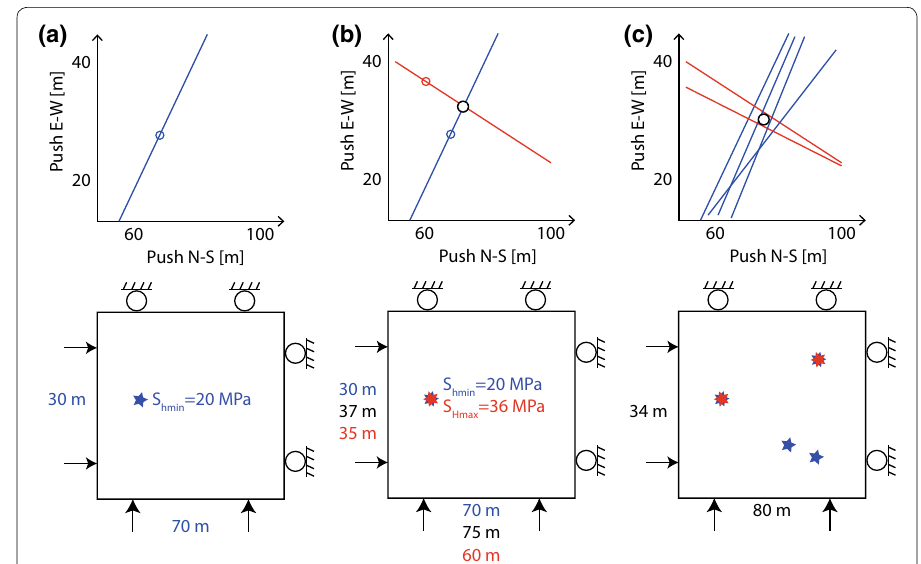
Fig. 2 Model calibration approach. Top row shows the usage of combination of displacement boundary conditions at the vertical model boundaries. Lower row shows the associated implementation in the model with stress magnitude data that are used for calibration. Red ( S Hmax ) and blue ( S hmin ) indicate the horizontal stress magnitudes and the associated possible boundary conditions that fit their respective value. a For a single S hmin data record the combinations of boundary conditions that satisfy the calibration data record is described by a linear function. One possible set of boundary conditions is indicated here. b An S hmin and S Hmax calibration data record can be modelled individually again by boundary conditions on a straight line each. However, if both S Hmax and S hmin should be satisfied the intersection of these two lines, indicated by a solid white dot in the top row, is the unique pair of boundary conditions that fits both. c If several S Hmax and S hmin data records are available, for each S Hmax and S hmin the linear function with the least mean difference between observation and model is derived. Then, the intersection of these two functions is used as the valid set of boundary conditions that minimises the differences between modelled and observed stress